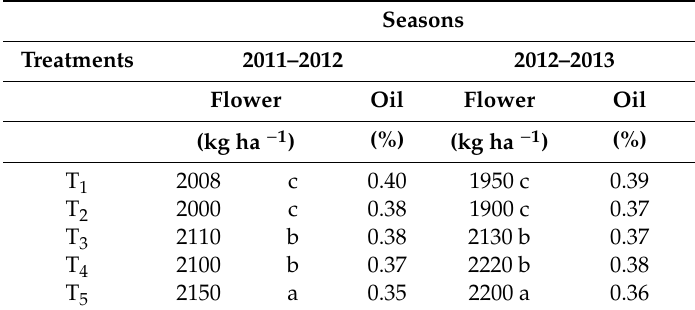
Table 5. E ff ect of treatments on fresh flower yield and essential oil percentage of chamomile crop